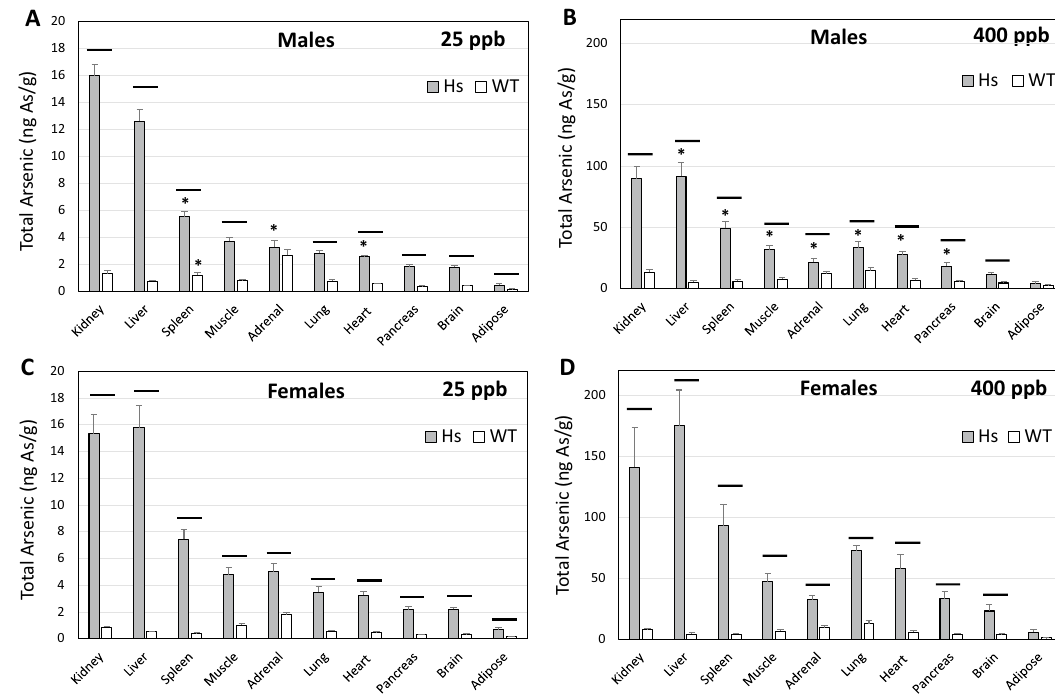
Figure 2. Concentrations of total arsenic in tissues of humanized (Hs) and wild-type (WT) male and female mice after 4-week exposure to 25-ppb ( A , C ) or 400-ppb ( B , D ) of inorganic arsenic in drinking water. Each bar and whisker represent mean and SEM value, respectively. For 25-ppb exposure, N = 6 for Hs males and WT males, and N = 8 for Hs females and WT females. For 400-ppb exposure, N = 7 and 8 for Hs males and WT males, respectively, and N = 10 and 11 for Hs females and WT females, respectively. Horizontal line marks significant difference between genotypes for individual tissue; asterisk marks significant difference between males and females of the same genotype (p <